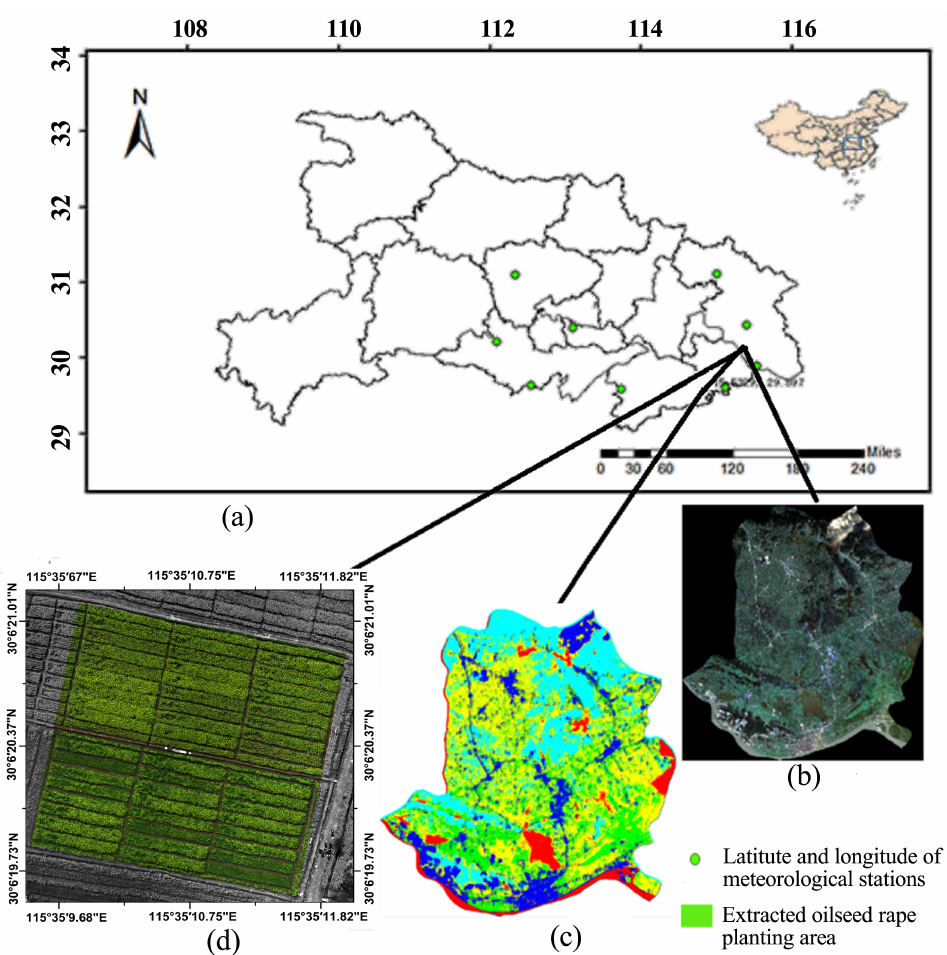
Figure 1. Study area. ( a ) Hubei province with meteorological stations in green. ( b ) A Gaofen-1 image of Wuxue city in 2015. ( c ) Extraction of oilseed rape cultivation area in Wuxue city. ( d ) Ground experimental